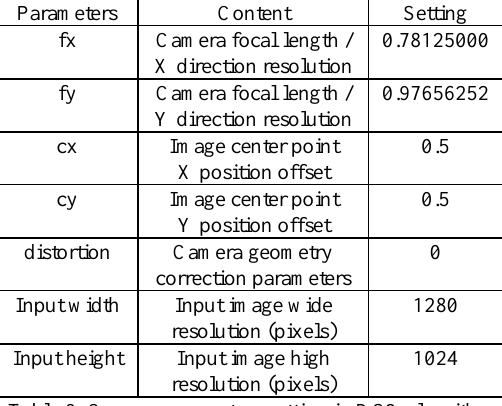
Table 3. Camera parameters setting in DSO algorithm